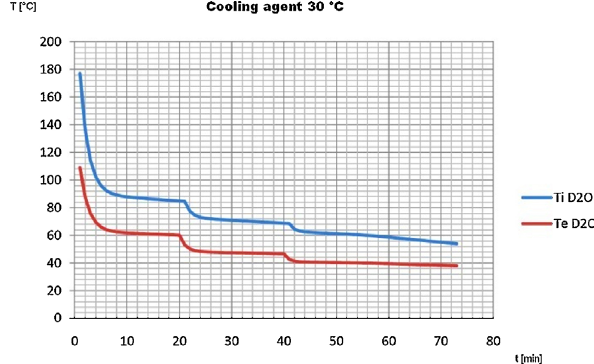
Figure 2 is a plot of temperature decrease of PHTS